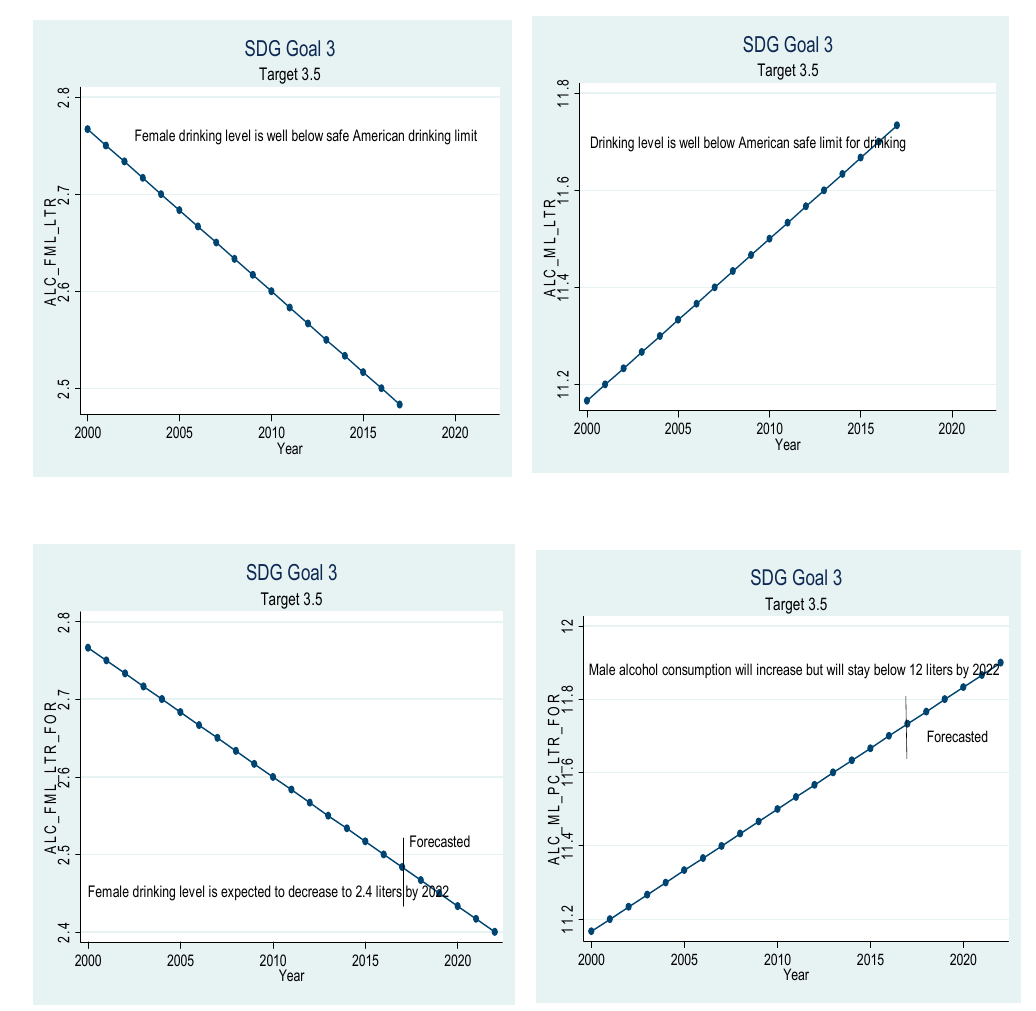
Figure 5. Sustainable development goal 3, target 3.5 (prevention of drugs and alcohol abuse) ex-post and ex-ante.